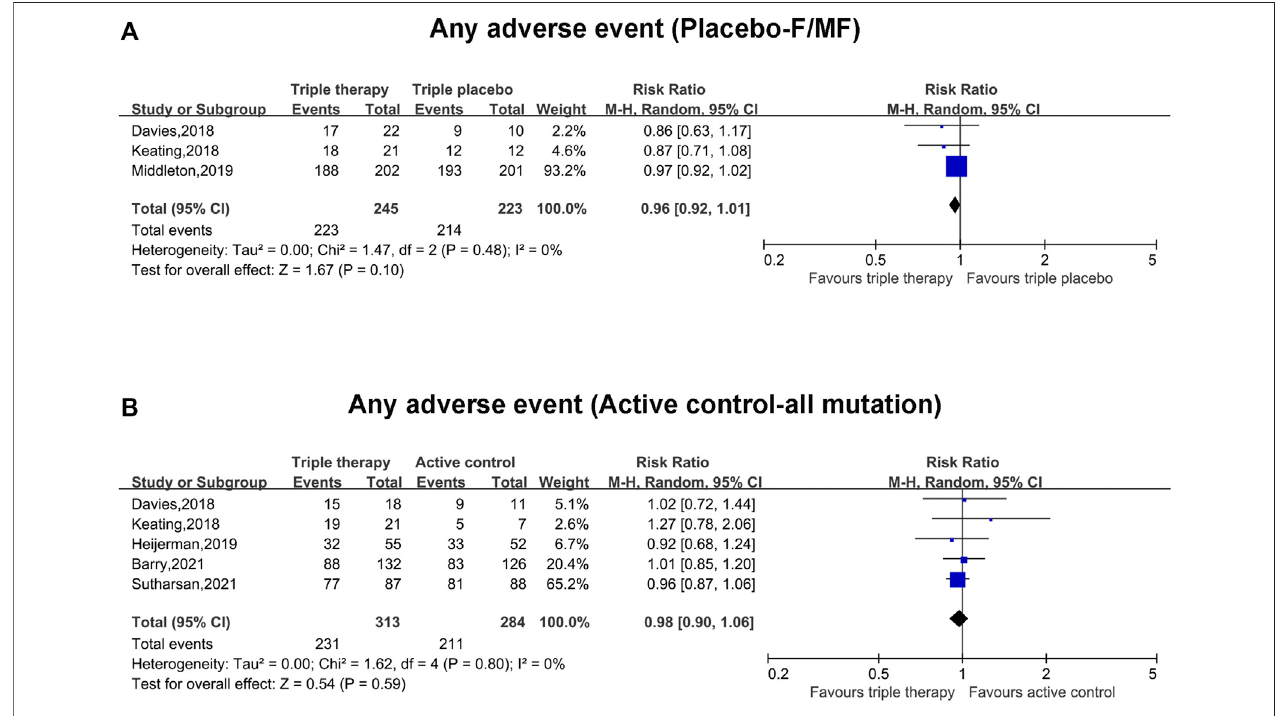
Adverse event Davies Keating Middleton